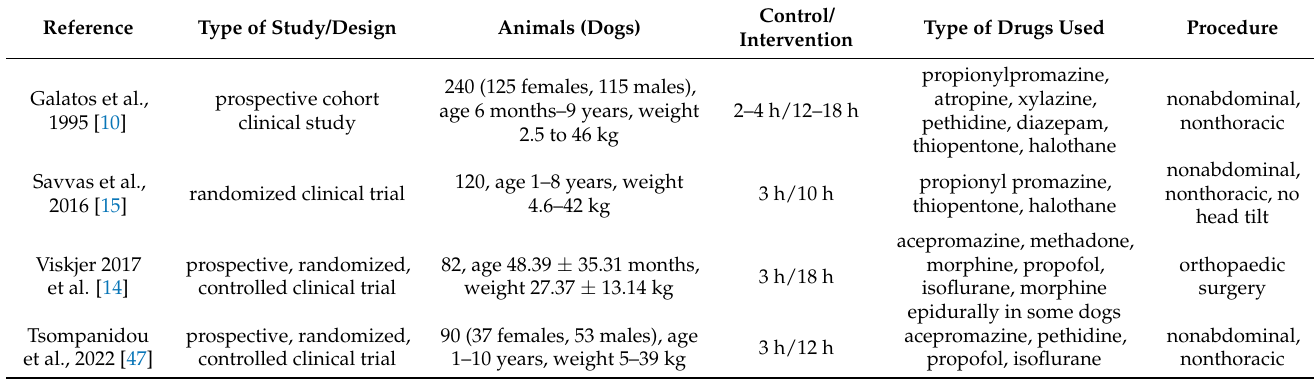
Table 1. Intervention: duration of fasting. Characteristics of the studies in dogs.